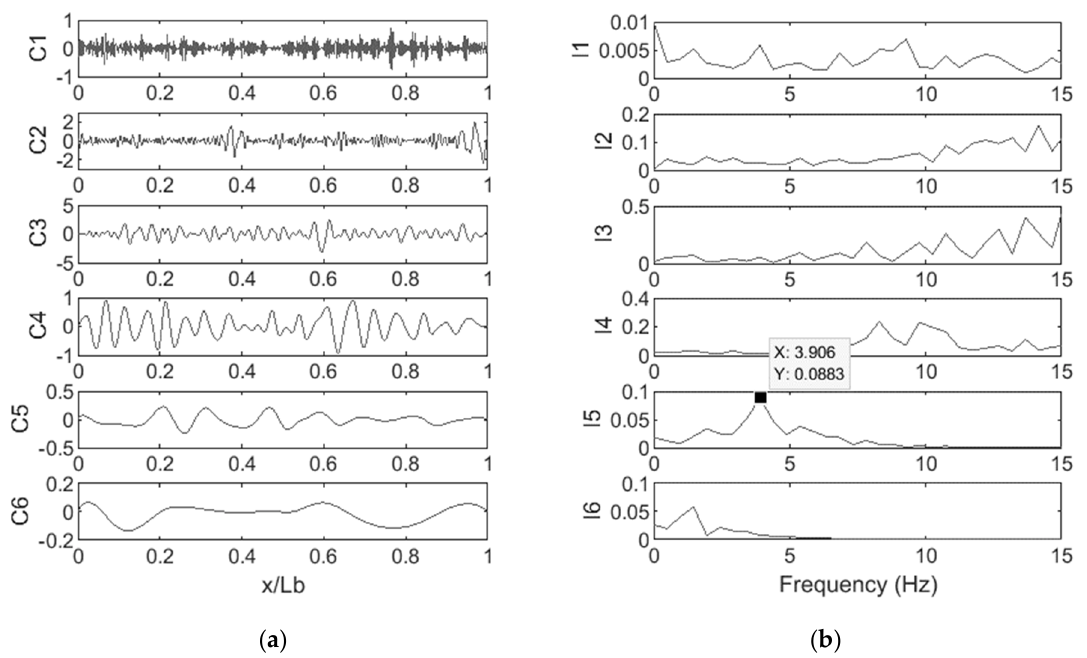
Figure 9. ( a ) IMFs obtained from the EEMD of the vehicle acceleration response and ( b ) FFT spectra of the IMFs.